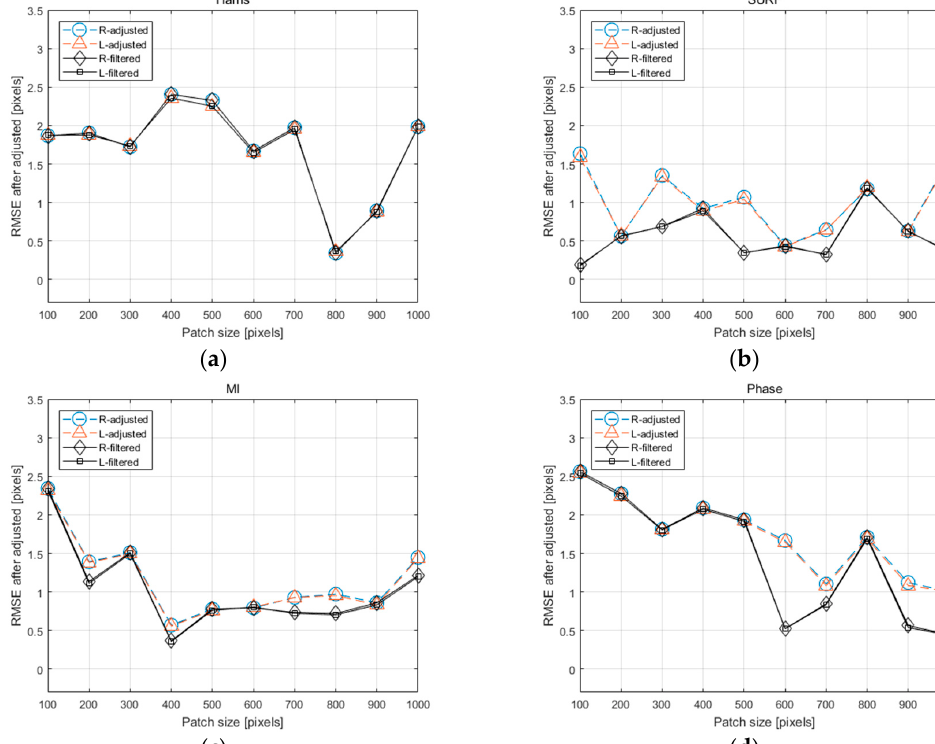
Figure 18. Reprojection errors (along-track Kompsat-3 original—after adjustment): ( a ) HARRIS–FREAK ( b ) SURF, ( c ) MI, and ( d ) PC.